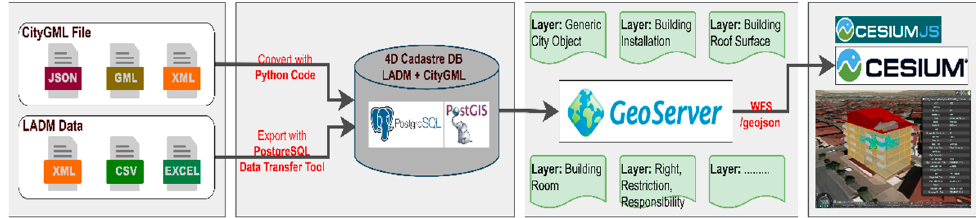
Figure 5. Workflow of processing steps to creating ADE 4D Cadastral Data Model and implemen- tation.